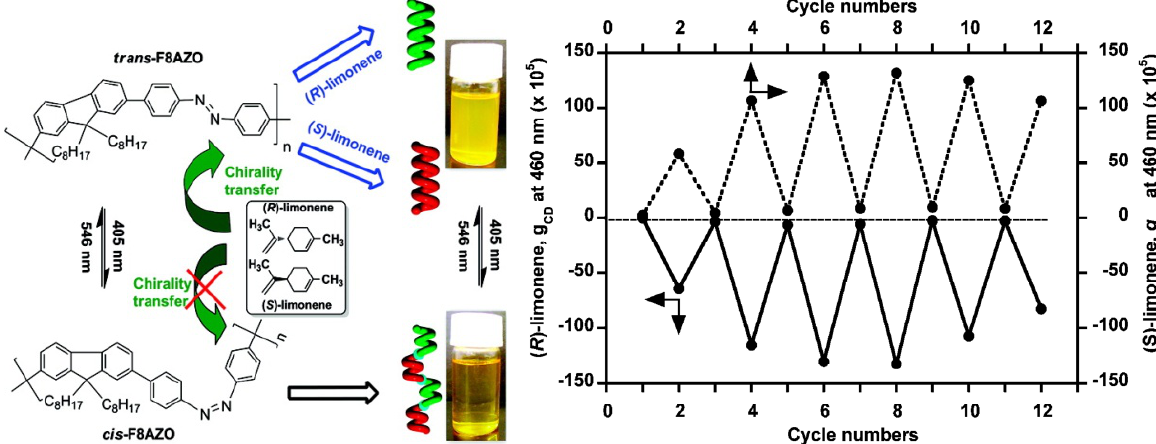
Figure 21. Right: Schematic illustration of unpolarized-light-driven chiroptical switching in CHCl /( S - or R -limonene)/IPA (0.3/1.5/1.2, v/v/v). Left: Change in the g 3 upon alternating photoirradiation cycles with 405 and 546 nm light [96]. Reproduced by permission of the American Chemical